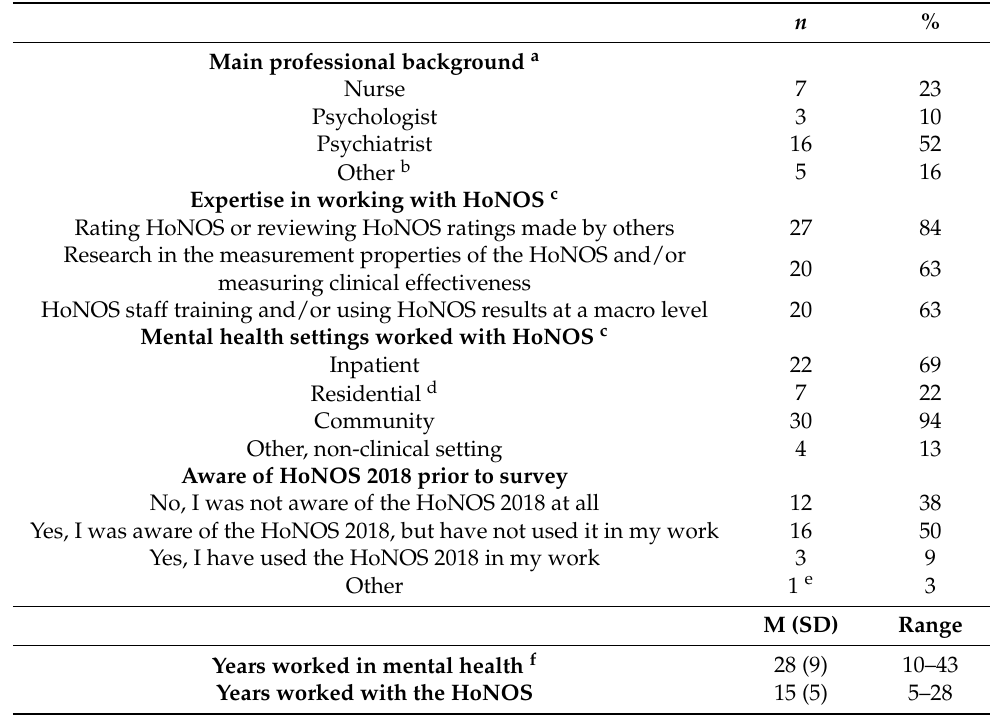
Table 2. Characteristics of experts who completed the survey (N =